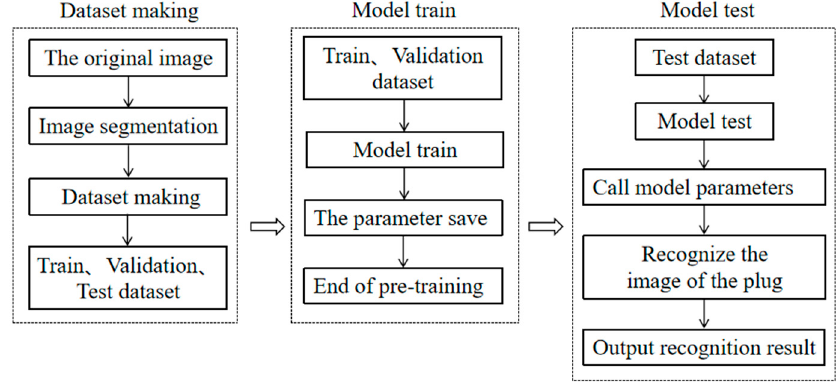
Figure 1. The procedure for missing broadcast detection.